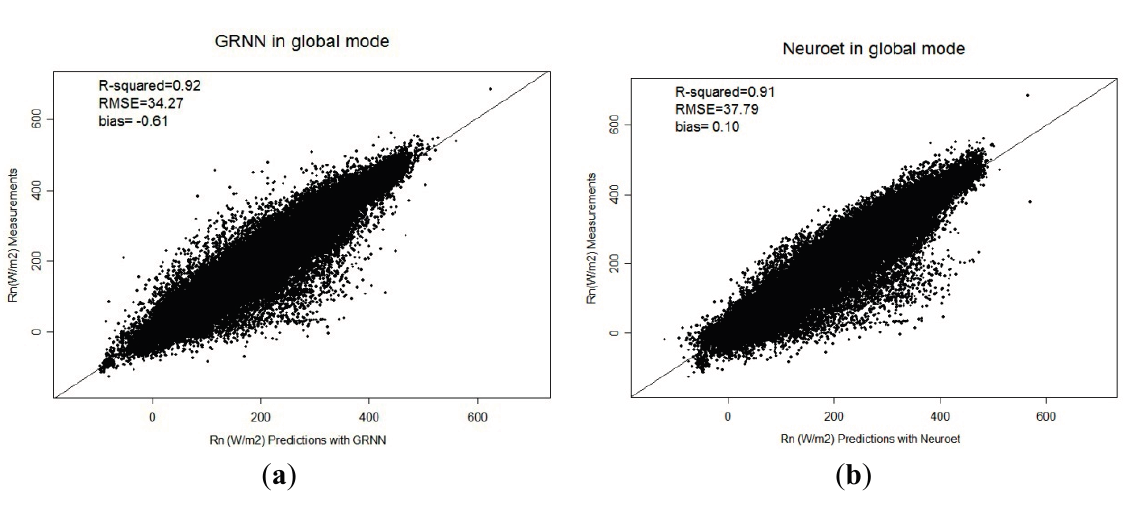
Figure 3. Scatter plot of predicted and measured R n by ( a ) GRNN and ( b ) Neuroet model in global mode.